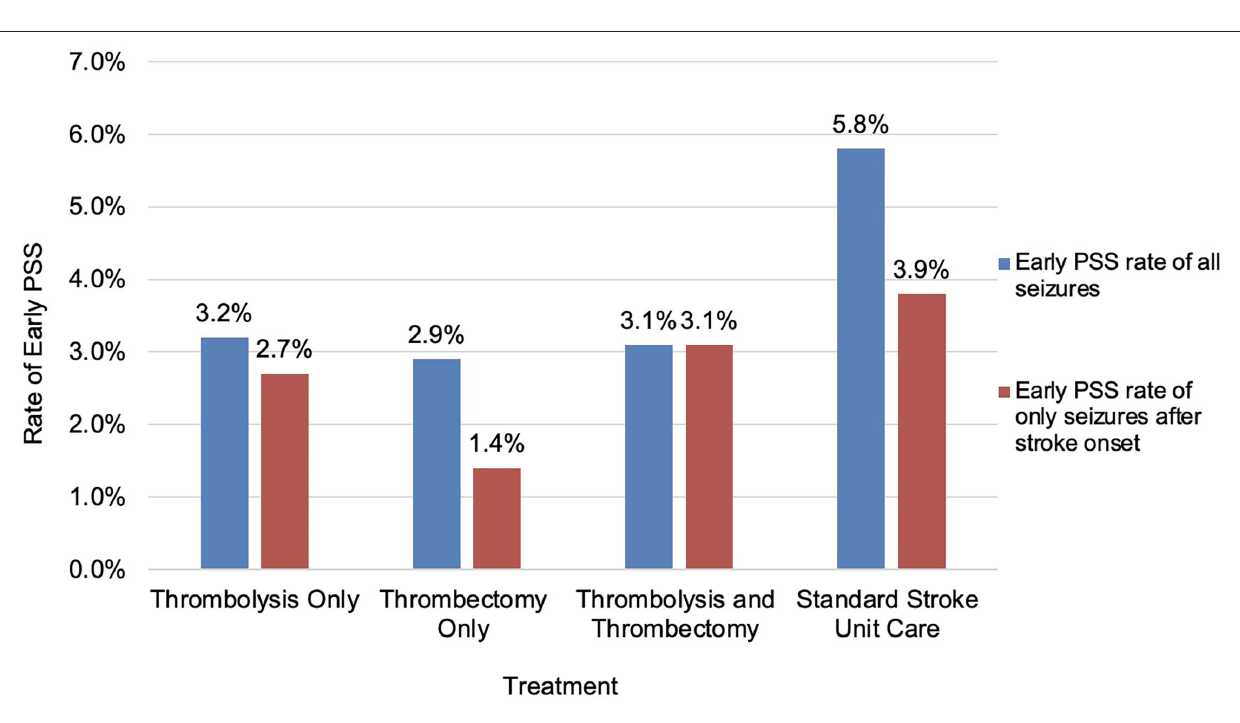
endogenous tPA have lower seizure thresholds (24). Reperfusion injury through oxygen-free radicals and/or calcium overload is